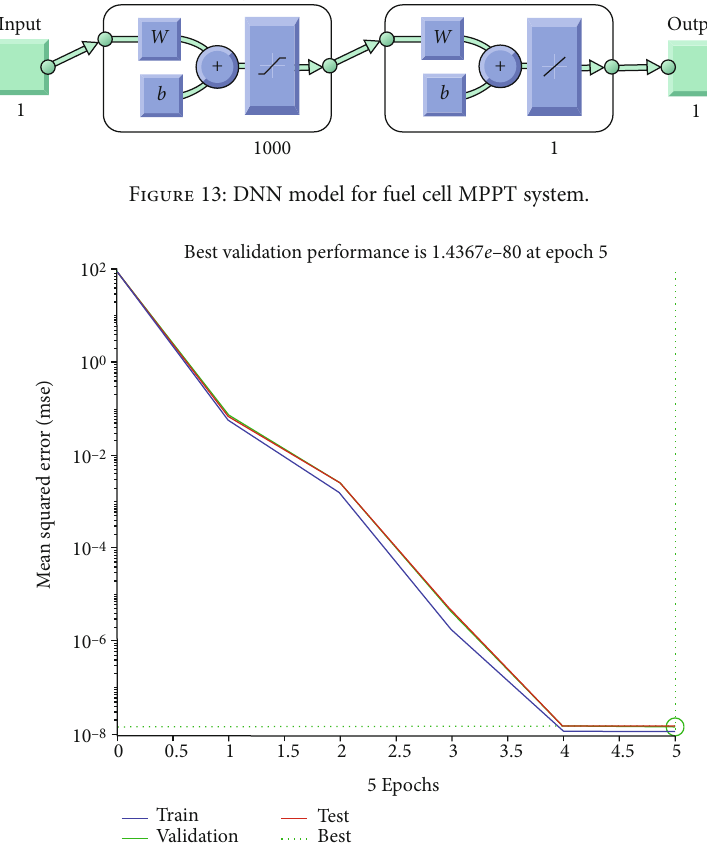
Figure 14: DNN-based fuel fl ow controller showing best validation performance.